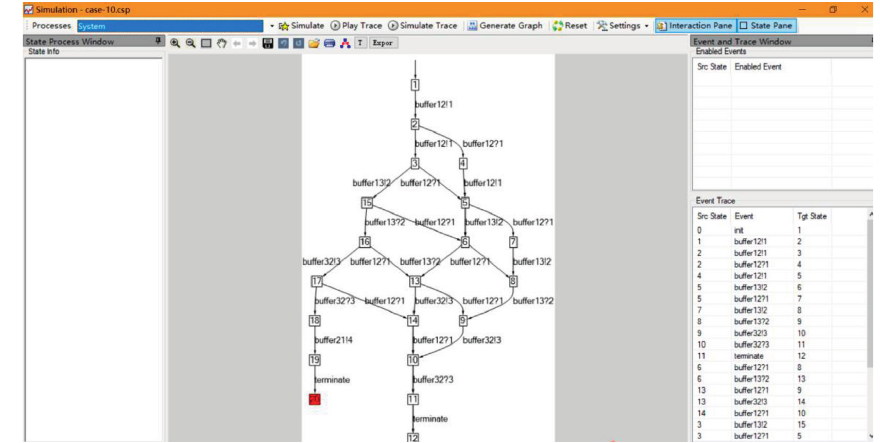
Figure 6: A snapshot of the asynchronous interaction behavior using the PAT